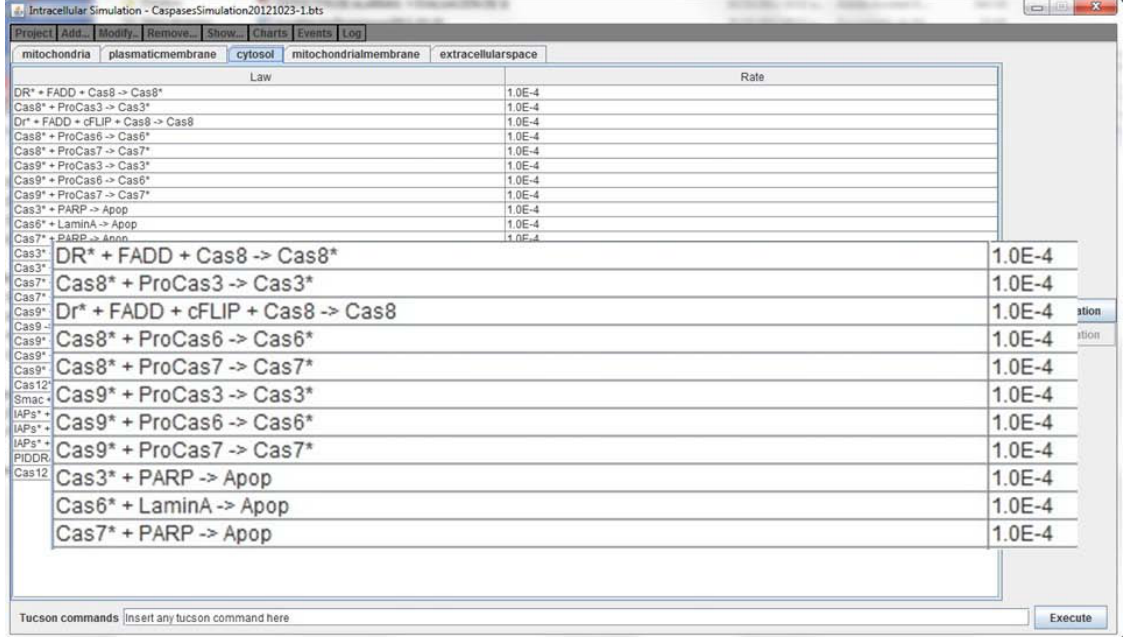
Figure 5: Setting chemical reactions.